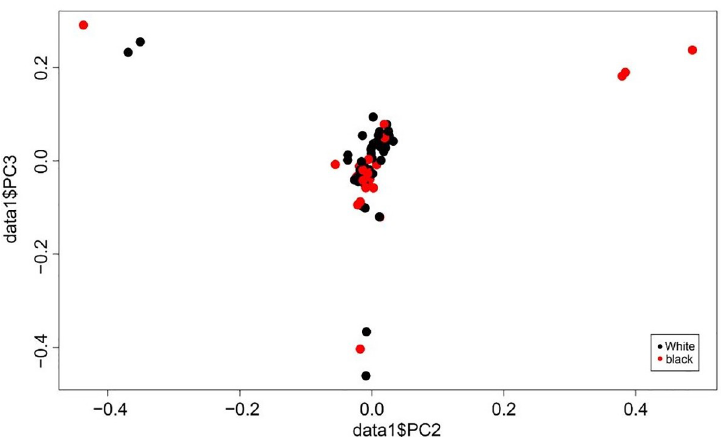
Fig 4. Principal component analyses of white and black-head Tan